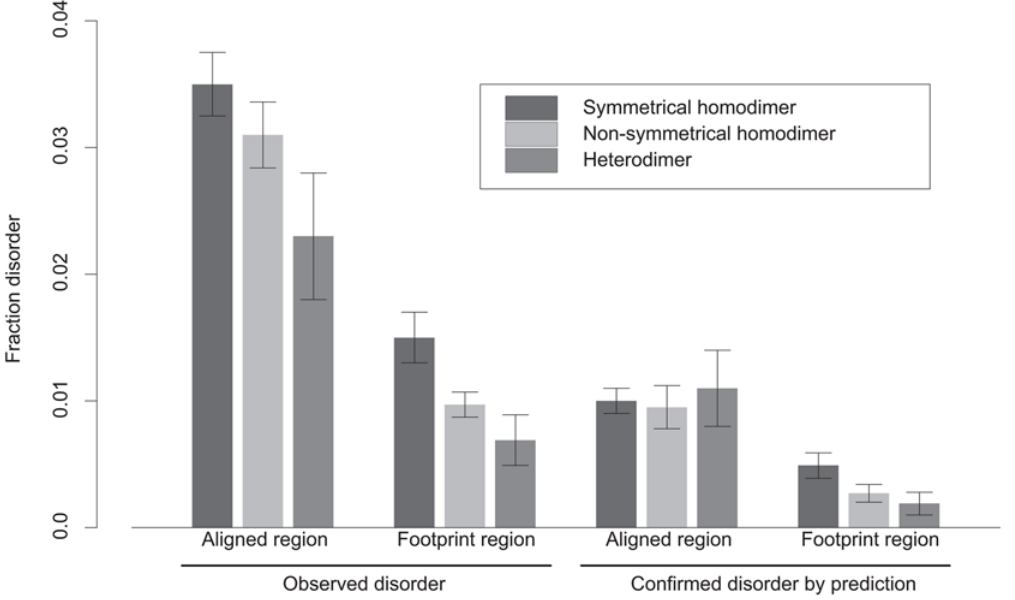
Figure 5. Average fraction disorder together with the standard error is plotted for three categories of oligomers: symmetrical, nonsymmetrical homodimers and heterodimers; for fraction disorder in the aligned and footprint regions. The ‘‘footprint region’’ extends from the first to the last residue in the alignment mapping CDD family to a given chain. ‘‘Aligned regions’’ are more extensive than footprint regions and cover footprint regions plus C and N- terminal protein regions.